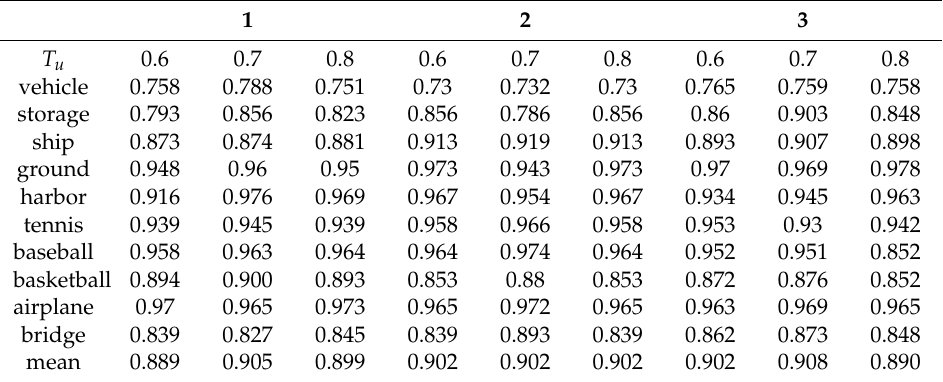
Table 5. The effect of the threshold to select the positive samples in the RPN on APs and